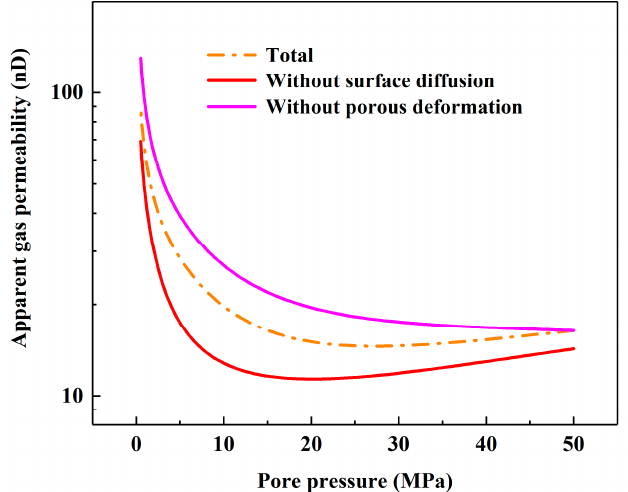
Figure 9. The AGP with different influential effects coupling ( r = 5 nm).